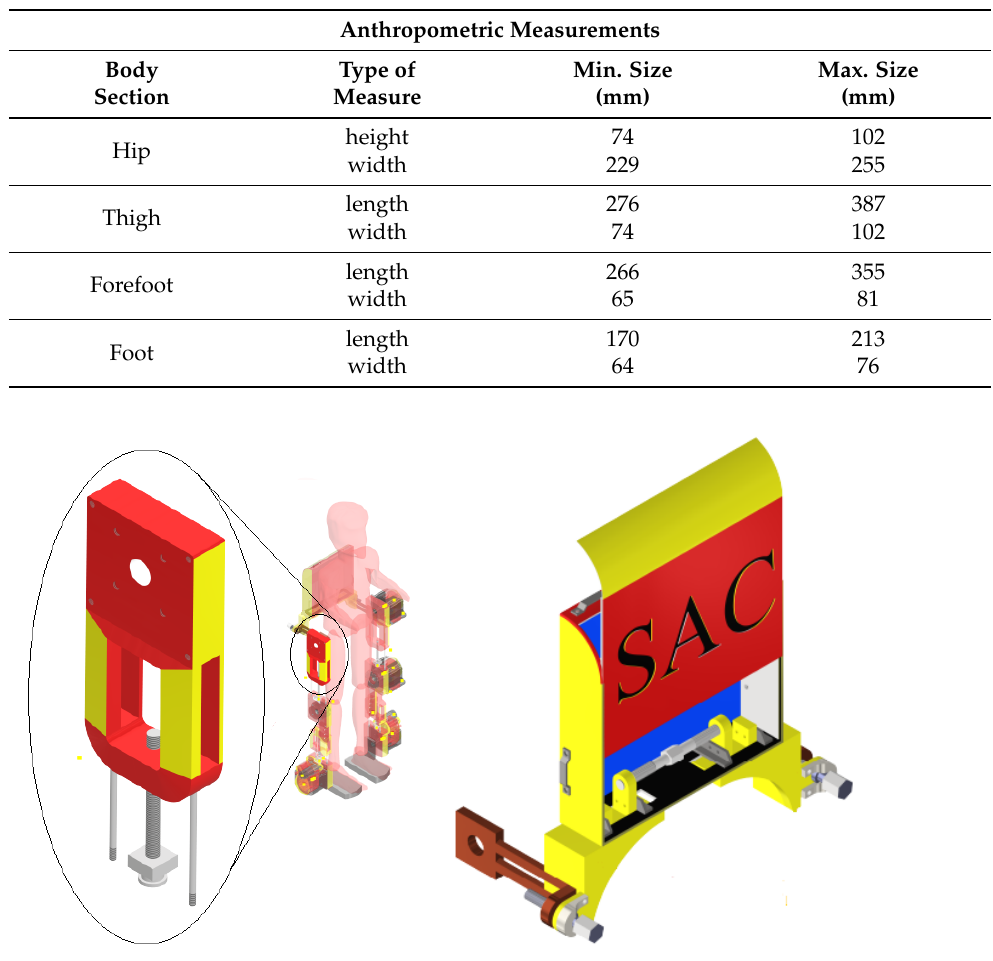
Table 1. Anthropometric measurements of Latin American children.